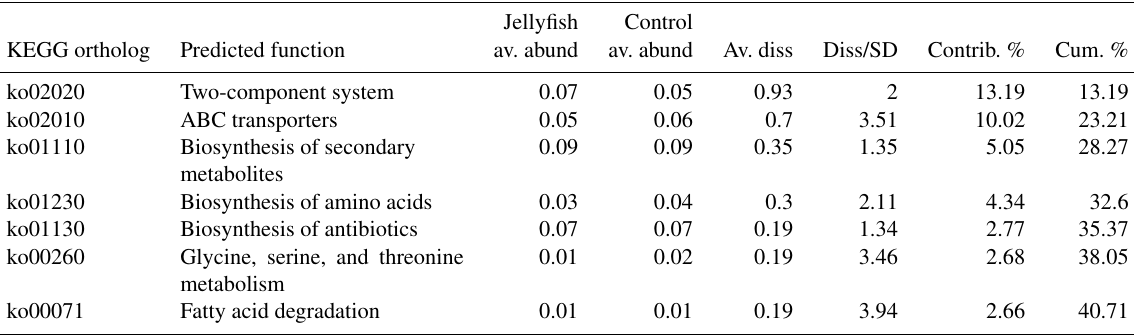
Jellyfish treatments and controls Average dissimilarity: